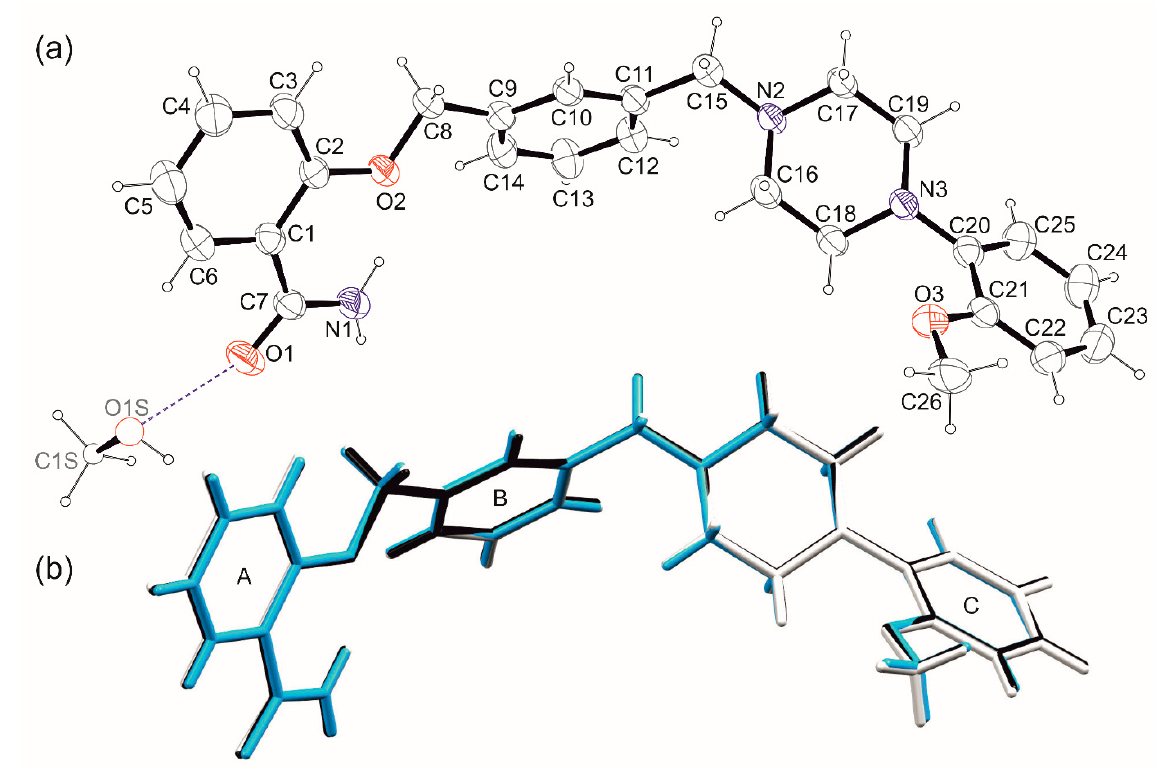
Figure 5. ( a ) Ortep [27] drawings of the 1-MeOH asymmetric unit with the atom numbering scheme. Thermal ellipsoids are presented at 30% probability. Methanol molecule with partial occupancy restrained to 0.5 is depicted with spheres of arbitrary radius. ( b ) Overlay of molecules of 1 from 1-MeOH (black), 1-MeOH-low (white), and 1-EtOH (turquoise) crystals. Aromatic rings are numbered with capital letters A–C.